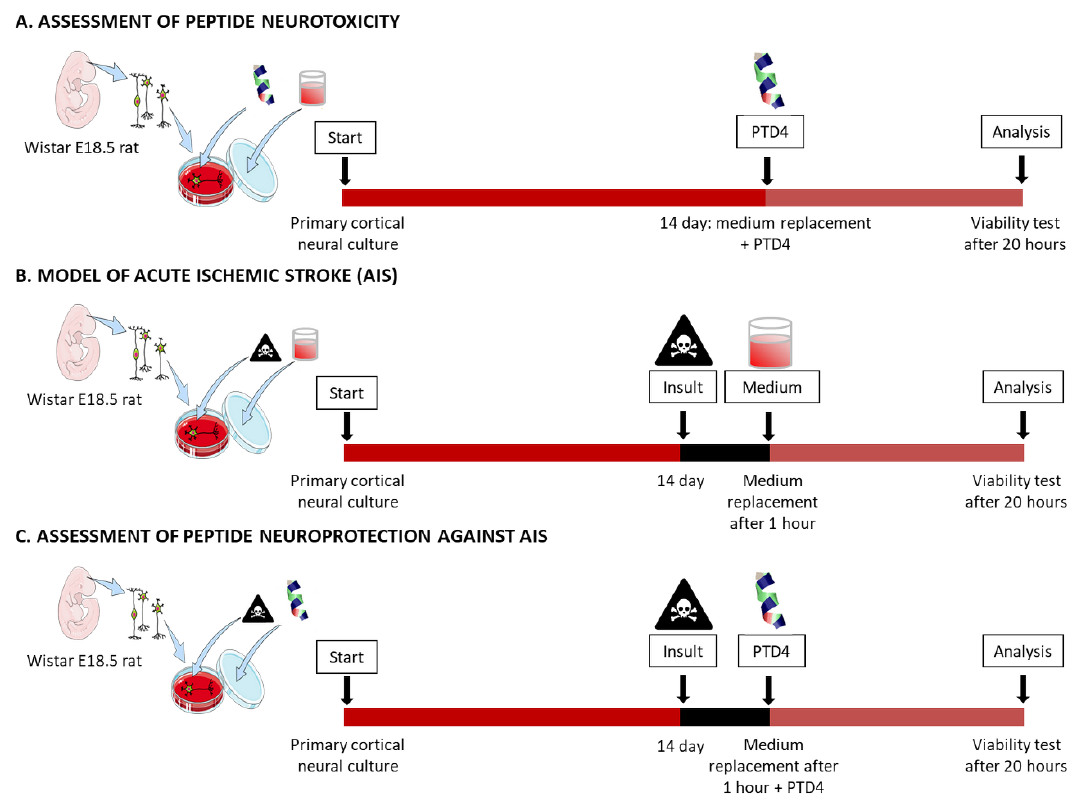
Figure 4. Experimental designs: peptide neurotoxicity ( A ), in vitro model of AIS ( B ), and peptide neuroprotection against AIS ( C ).